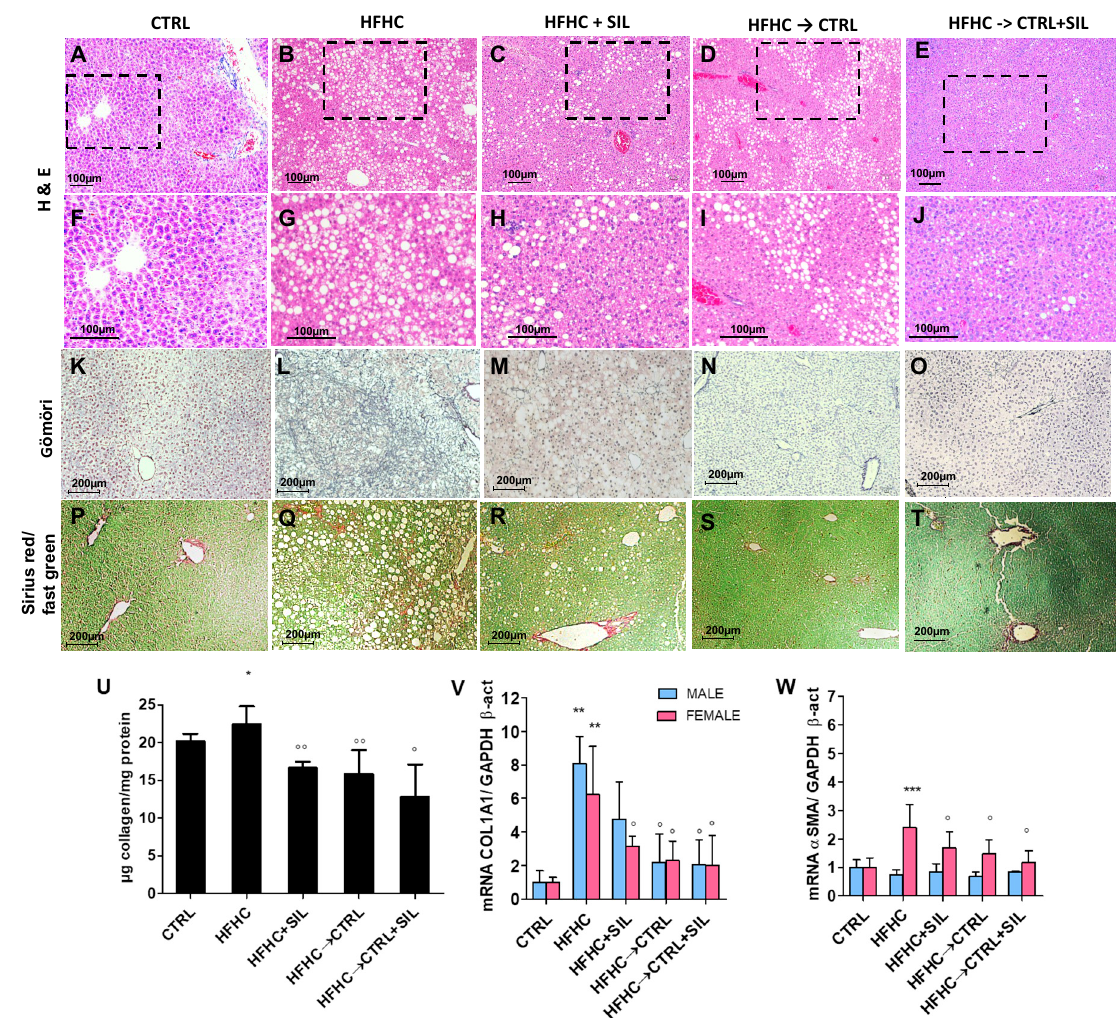
suggests that the pro-fibrotic environment is still active in females, whereas in males is likely that all HSC cells have become myofibroblasts.